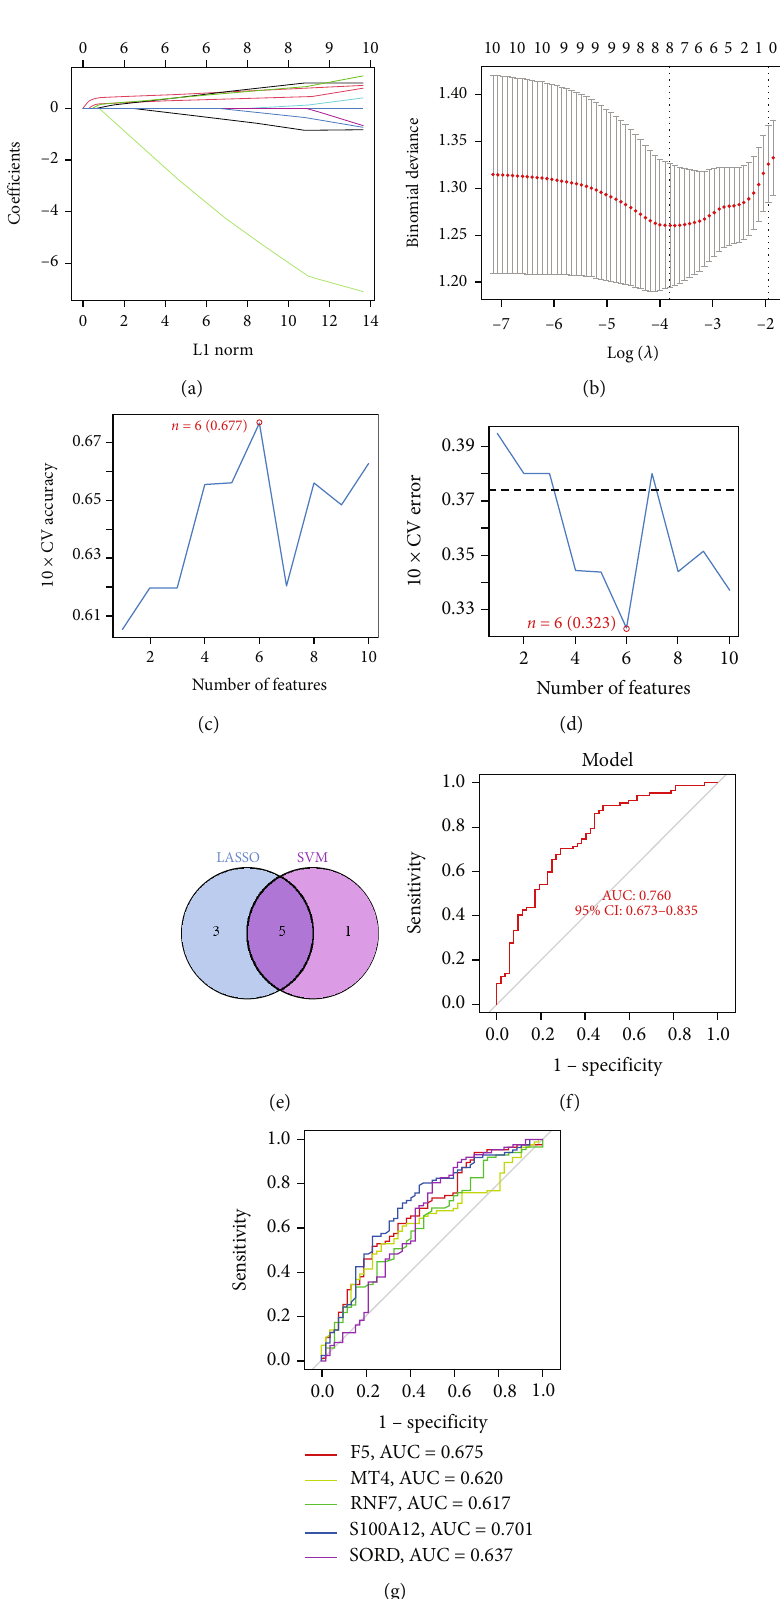
Figure 3: Identi fi ed 5 DE-CRGs as marker genes for CAD. (a, b) Eight DE-CRGs were identi fi ed as candidate marker genes by LASSO analysis. (c, d) Six DE-CRGs were identi fi ed as candidate marker genes by SVM-RFE analysis. (e) Venn diagram of intersection analysis. (f) ROC curve and corresponding AUC value for the logistic regression model. (g) ROC curves and corresponding AUC values for the 5 marker